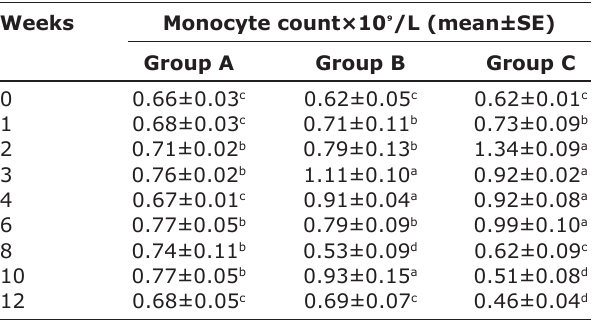
Table-9: Monocyte count in female goat’s postinoculation with C. pseudotuberculosis and MA.